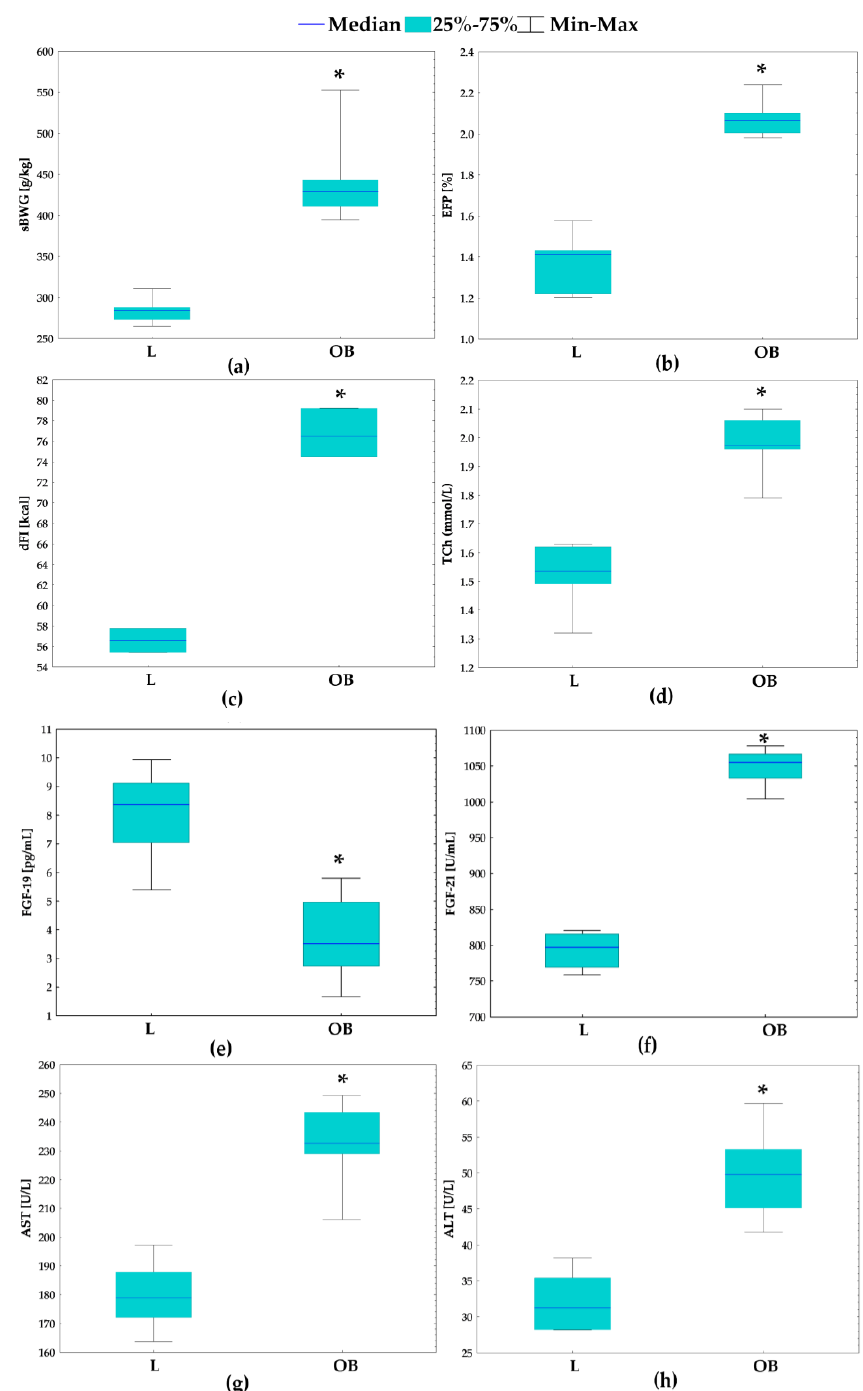
Figure 1. Specific rate of body weight gain (sBWG, g/kg) ( a ), epididymal fat pad (EFP, %) ( b ), daily feed intake (dFI, kcal) ( c ), concentrations of serum: total cholesterol (TCh, mmol/L) ( d ), fibroblast growth factor 19 (FGF-19, pg/mL) ( e ), fibroblast growth factor 21 (FGF-21, U/mL) ( f ), liver aspartate transaminase (AST, U/L) ( g ) and liver alanine transaminase (ALT, U/L) ( h ). L — lean intact ( n = 6); OB — obese intact ( n = 6); * p < 0.05 vs. L.